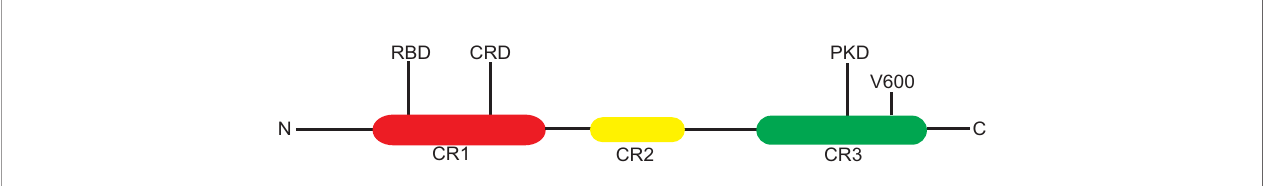
FIGURE 2 | The structure of BRAF gene. N, C, amino and carboxyl end; RBD, Ras-binding domain; CR, conserved region; CRD, cysteine-rich domain; PKD, protein kinase domain; CR1/2/3; conserved region-1/2/3, CR1 contains RBD and CRD, V600E mutation occurs in